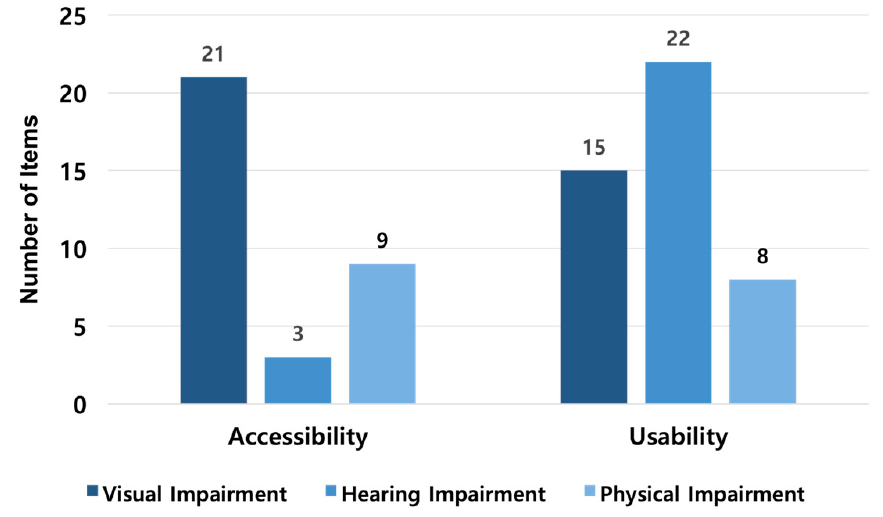
Figure 2. Number of accessibility and usability items by type of impairment.